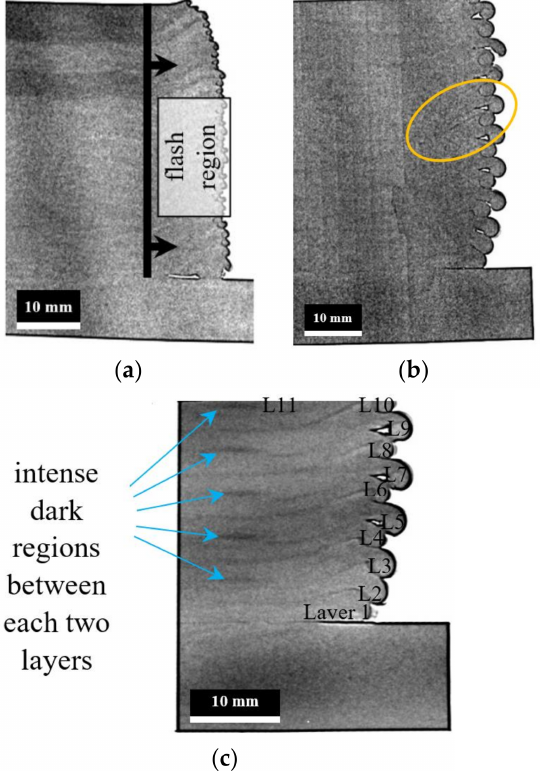
Figure 6. Interferometry transmission images: ( a ) 10 mm slab from ingot A; ( b ) 10 mm slab from ingot B. The vertical feature is the result of surface roughness, not internal defects. Encircled area shows the layering structure; ( c ) 20 mm slab from ingot B (polished half). The interlayer regions are clearly visible in this image and shown with arrows. This snapshot shows 11 deposited layers, denoted on the image (Layer 1, L2, . . .